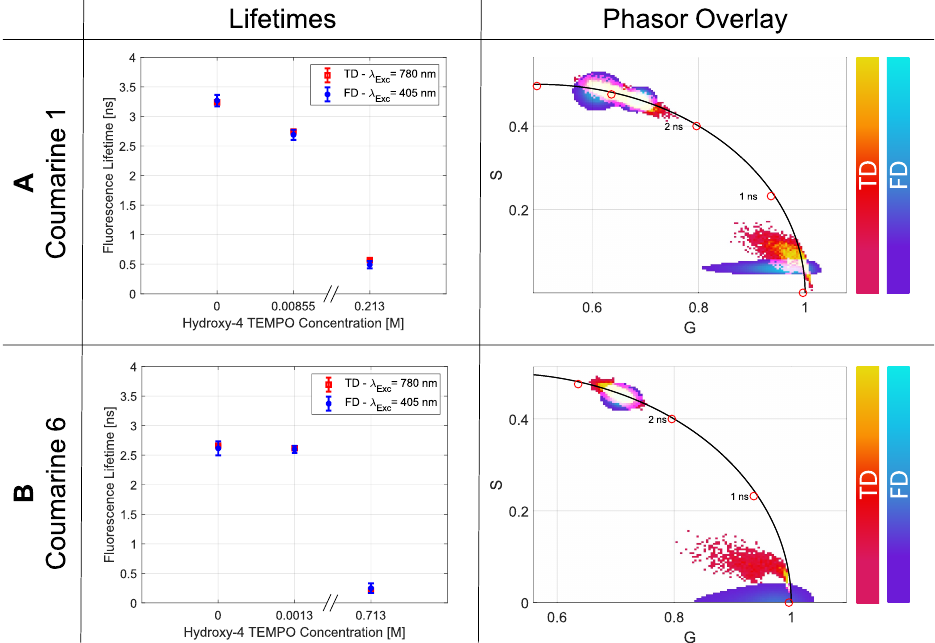
Figure 5. Results of the fluorescence lifetimes and phasor plot for the quenching series of coumarine 1 are illustrated in ( A , B ) for coumarine 6. With the help of 4-hydroxy TEMPO, it is possible to decrease the fluorescence lifetime to a specific